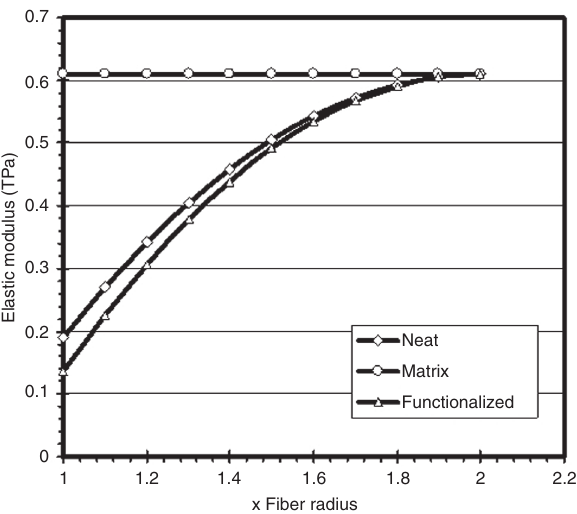
Figure 7 Variation of axial stiffness along the radius of the composite in the interphase region for neat and functionalized carbon nanotube systems